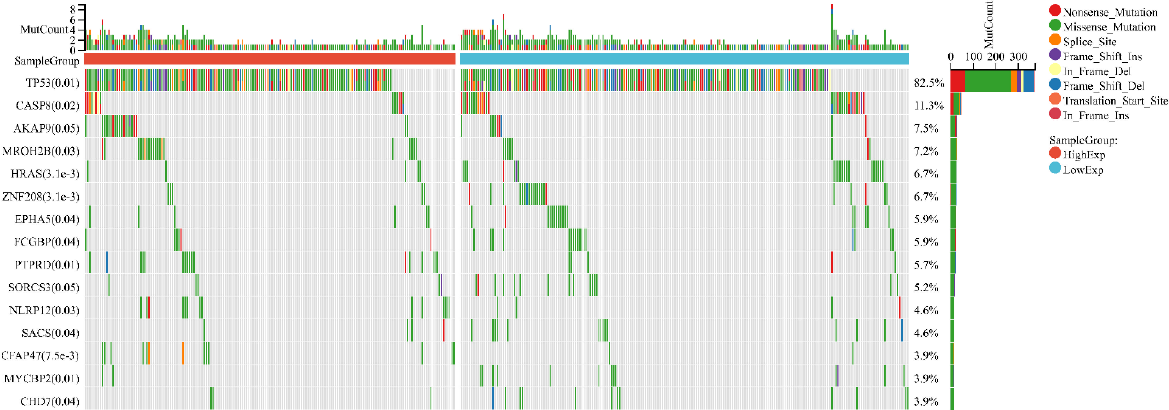
Figure 5. Variation in gene mutation frequency with FDCSP in HNSC.